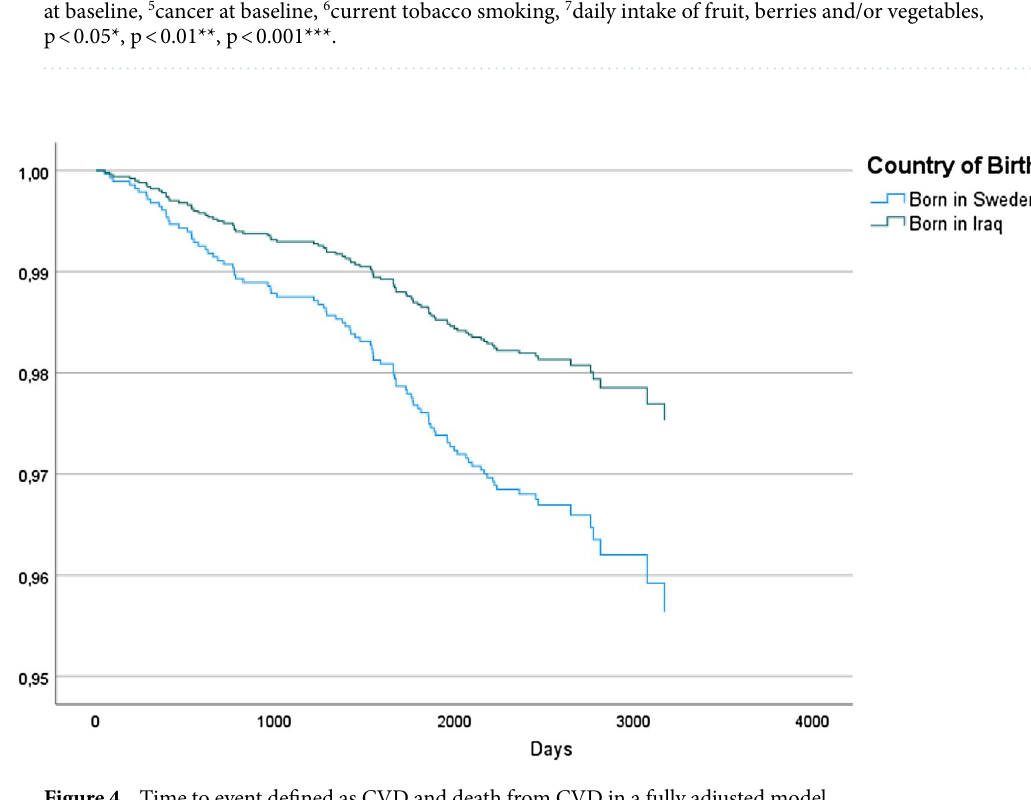
Figure 4. Time to event defined as CVD and death from CVD in a fully adjusted